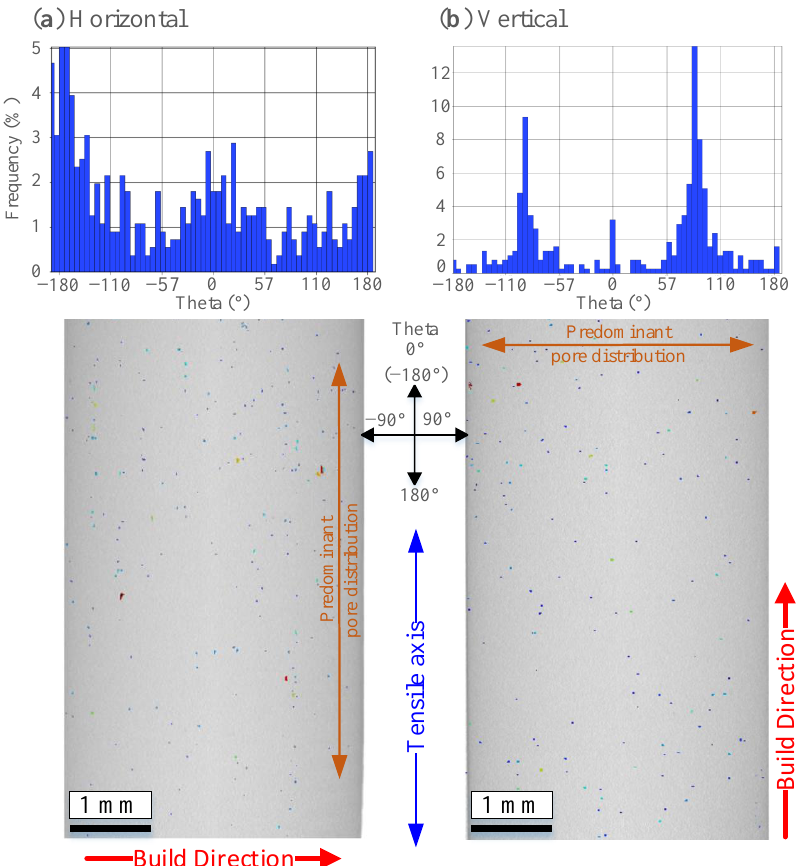
Figure 6. Reconstructed CT images of the ( a ) horizontal and ( b ) vertical tensile samples.